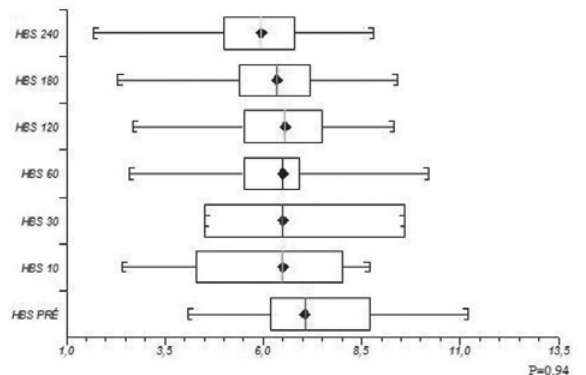
Fig. 3 – Dosagens de hemoglobina sérica (HBS) previamente e nos diferentes tempos da circulação extracorpórea